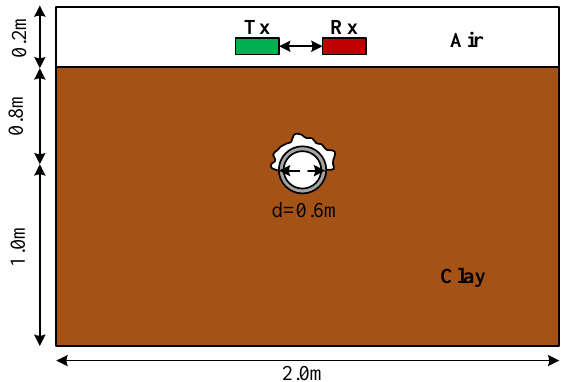
Figure 8. Schematic diagram of model with cavity disease on the upper part of pipeline.